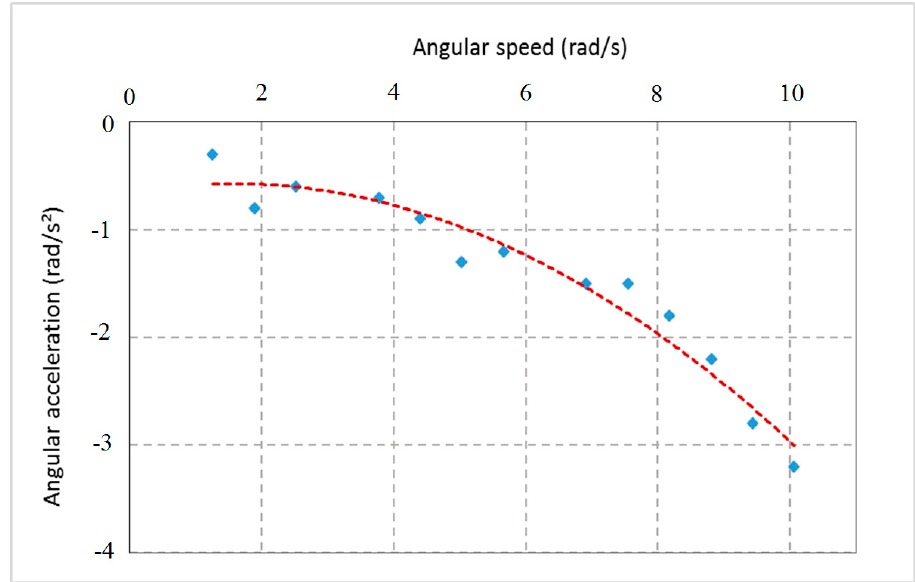
Figure 18. Relationship between the angular speed and angular acceleration of the designed flight mill.